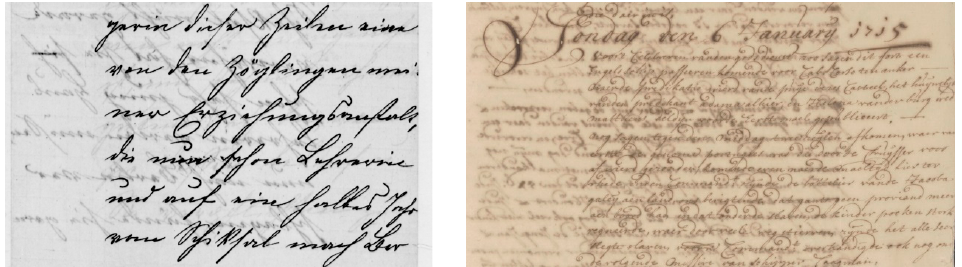
Figure 5. Example of ink-bleed degradation in handwritten documents from DIBCO database (left) from 2016 and (right) from 2017 databases.